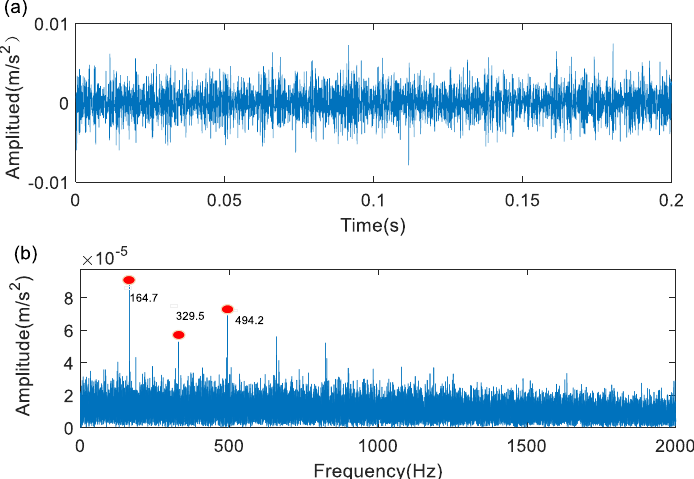
Figure 20. Results of impulse response wavelet on inner ring fault: ( a ) filtered signal; ( b ) the envelope spectrum of the filtered signal.